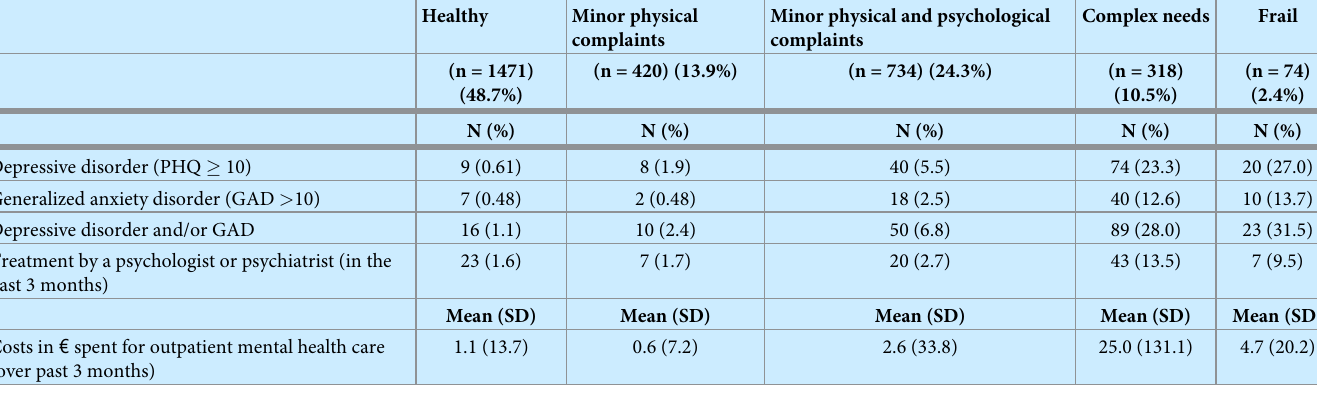
Table 3. Distribution of mental disorders and mental health care use in the five different